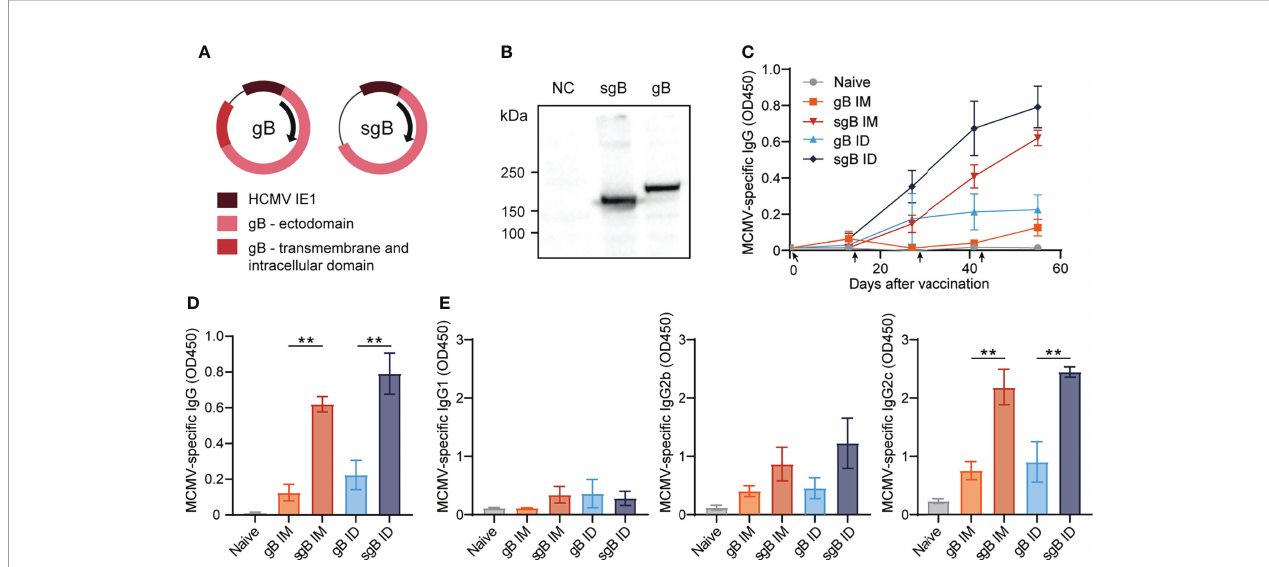
FIGURE 1 | Booster vaccination with DNA vaccines encoding soluble gB elicits robust IgG responses against CMV. (A) Schematic representation of the DNA vaccines encoding gB or a soluble version of gB (sgB). (B) Western blot showing expression of sgB and gB proteins following transfection of the DNA vaccines into B16F10 cells. Negative control (NC) only received the transfection agents. (C) Kinetic analysis of the MCMV-speci fi c IgG response in serum. Mice were vaccinated intradermally (ID) or intramuscularly (IM) four times at a two-week interval with 10 µg of sgB or gB DNA vaccine. At different time points blood was taken and serum was extracted to analyze the MCMV-speci fi c IgG antibody response. Data shown are mean values ± SEM (n=4 per group). Arrows indicate vaccine injection time- points (day 0, 14, 28, 42). (D) Presence of MCMV-speci fi c IgG antibodies for the different vaccinations two weeks after the fourth vaccination. Experiments were performed twice with similar outcome. (E) Presence of MCMV-speci fi c IgG1, IgG2b and IgG2c subclasses for the different vaccinations two weeks after the fourth vaccination. Experiments were performed twice with similar outcome. One-way ANOVA was used for statistical analysis.